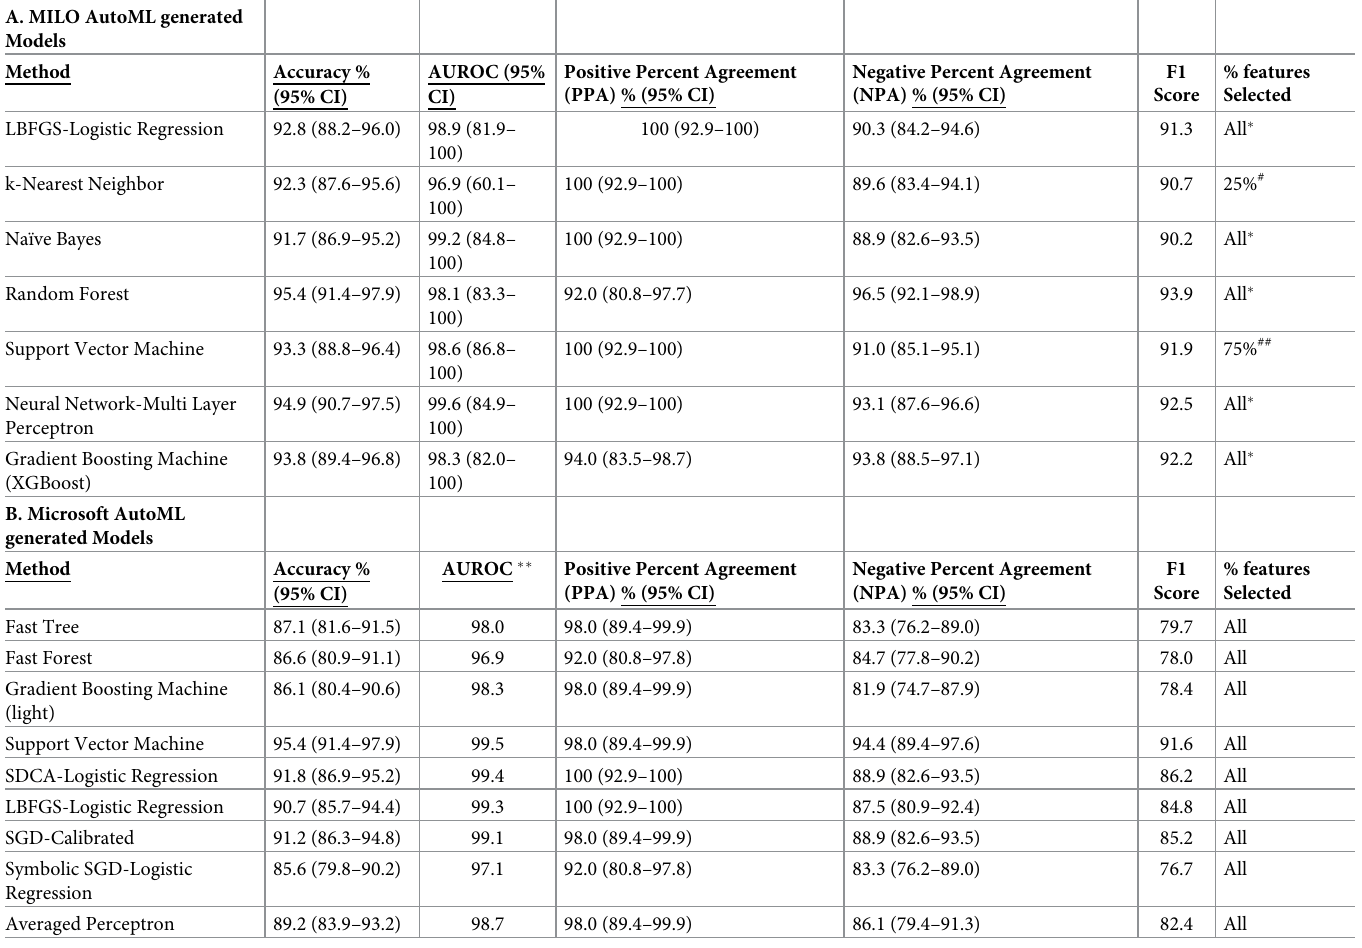
Table 3. Machine learning algorithm generalization performance for top models produced by Platforms A and